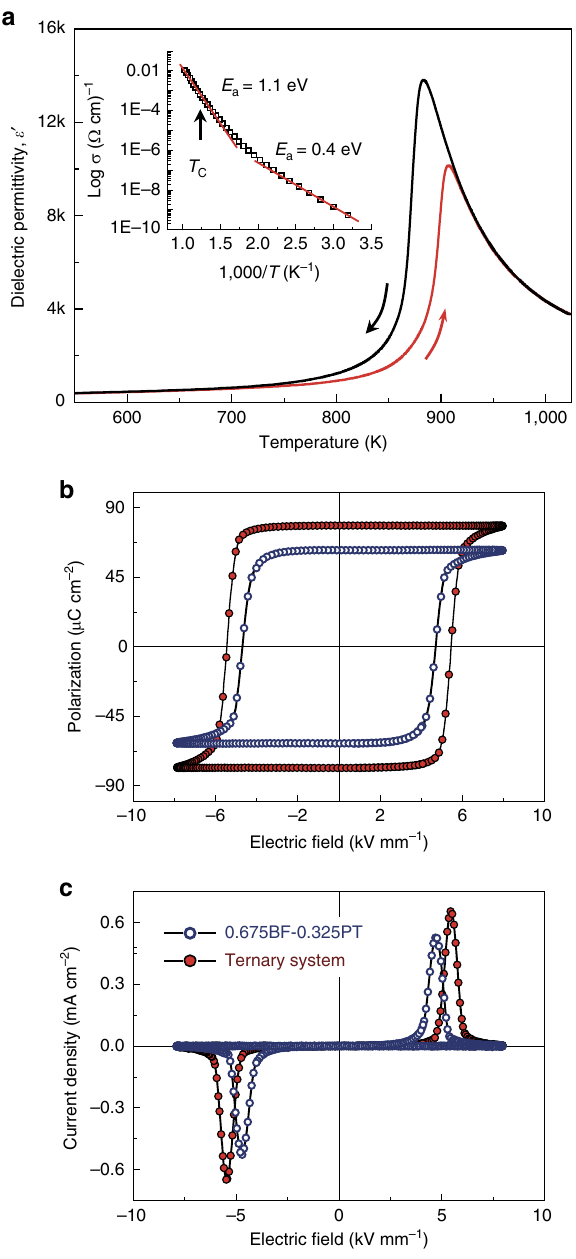
Figure 2 | Ferroelectric properties. ( a ) Temperature dependence of the relative permittivity at 1MHz of the Bi 0.68 Pb 0.32 Fe 0.655 Mn 0.025 Ti 0.32 O 3 ceramic, showing significant thermal hysteresis on a heating and cooling cycle (Inset: dc conductivity ( s ) vs inverse absolute temperature ( T ). Electrical ordering temperature ( T C ) and activation energy ( E a ) values are indicated). ( b ) P-E hysteresis loops and ( c ) current density curves for the ceramic under study (ternary system) and those for the MPB composition of the binary system (0.675BiFeO 3 –0.325PbTiO 3 ) for